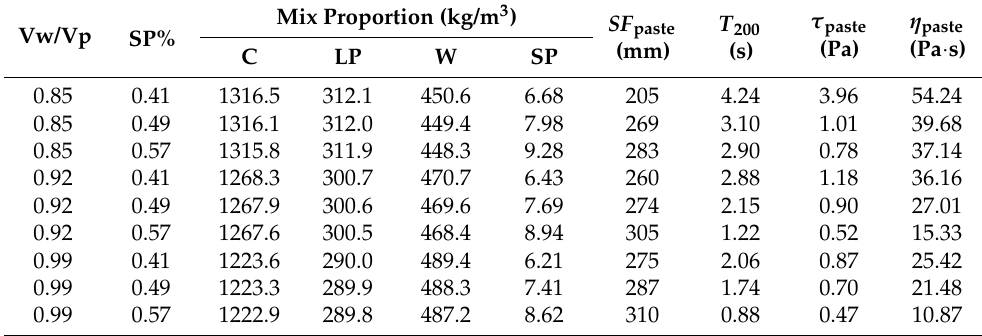
Table 10. Mix proportions and test results of paste in series 4.